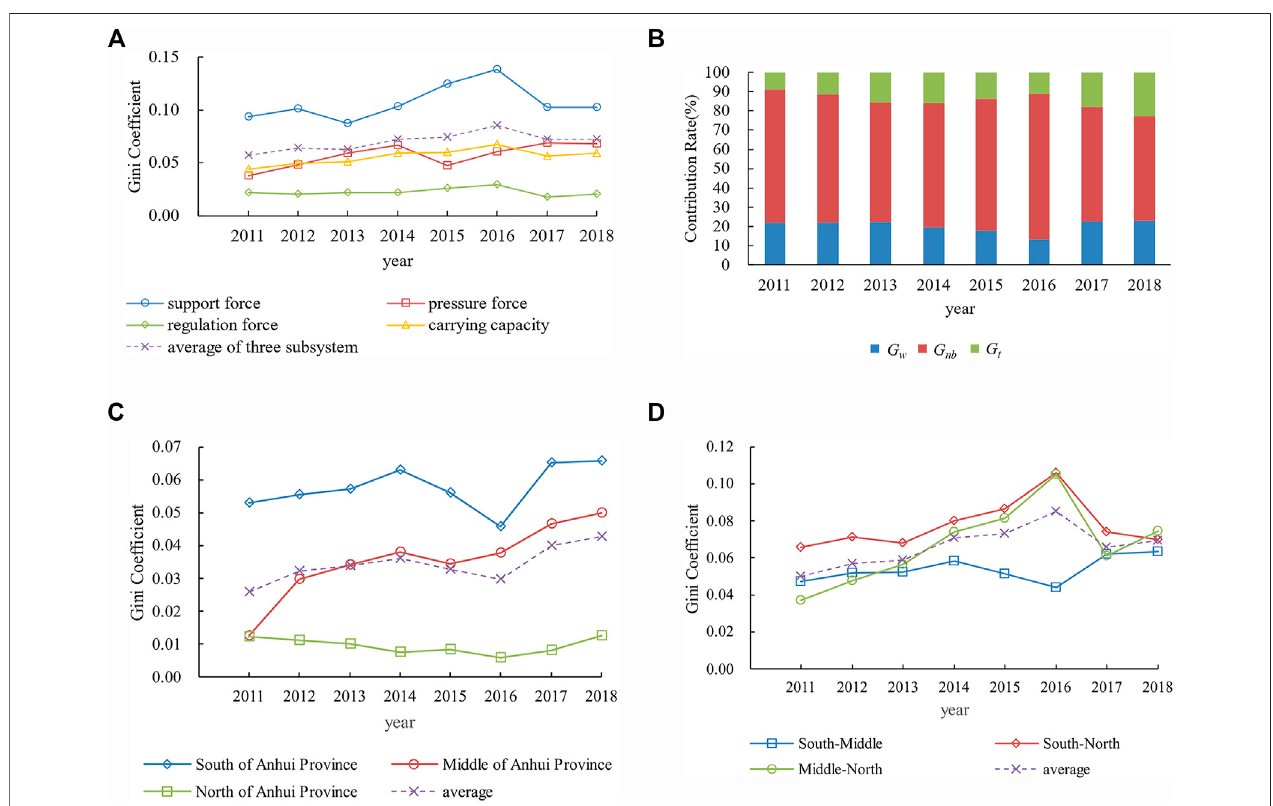
FIGURE9| Theresult ofDagum Ginicoef fi cientand itsdecomposition. (A) ThetotalGinicoef fi cientofAnhuiProvince from2011to2018. (B) Thecontributionrate of G w , G nb and G tin from 2011 to 2018. (C) The Gini coef fi cient within subregions in Anhui Province from 2011 to 2018. (D) The extended Gini coef fi cient between subregions in Anhui Province from 2011 to 2018.